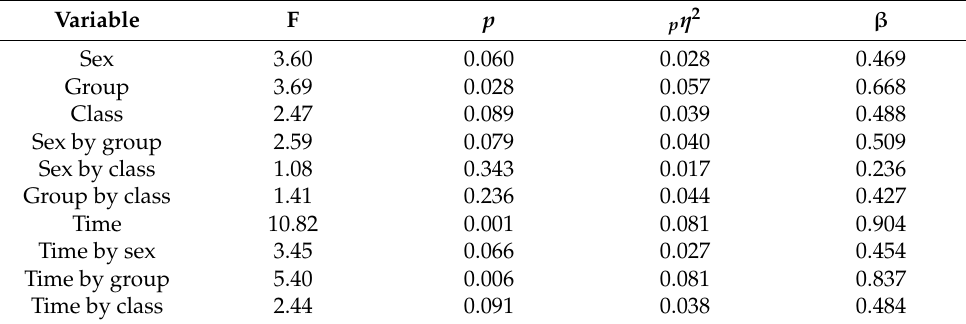
Table 2. Math test results.